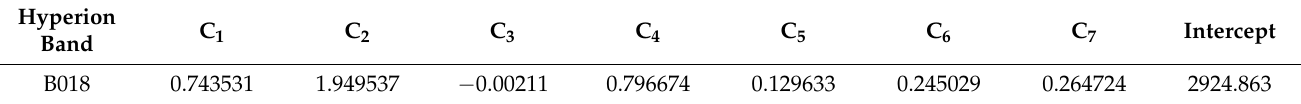
Table 1. Sensitivity of band selection in the SAM-HIT algorithm.